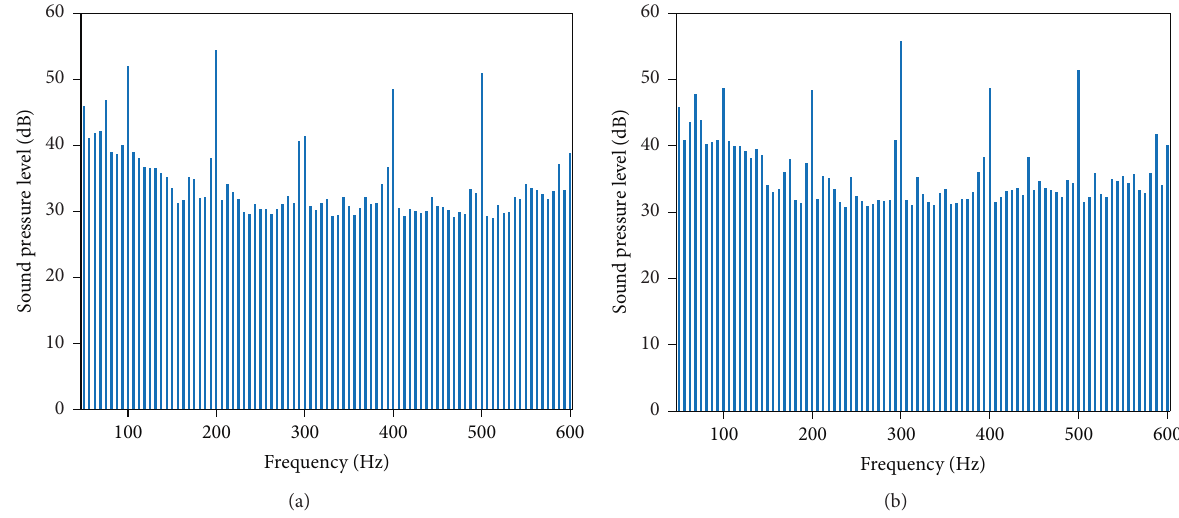
Figure 21: Spectrum characteristics of core noise. (a) Vertical to the core plane. (b) Parallel to the core plane.